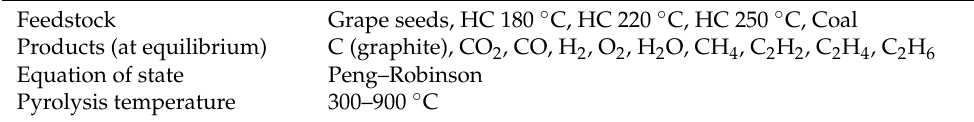
Table 2. Summary of parameters used in the Aspen Plus simulations.